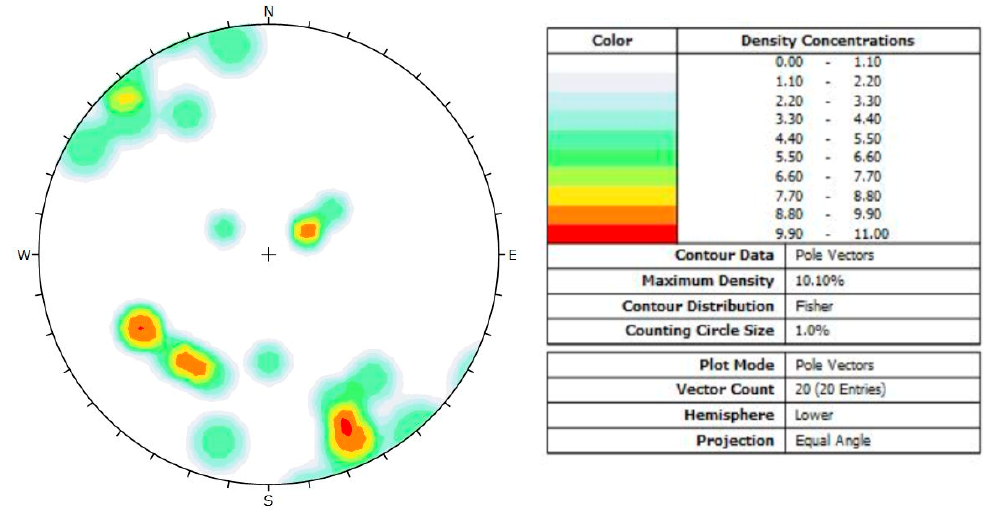
Figure 6. Schmidt diagram poles of cracks (discontinuities) in the Laže 1 quarry.